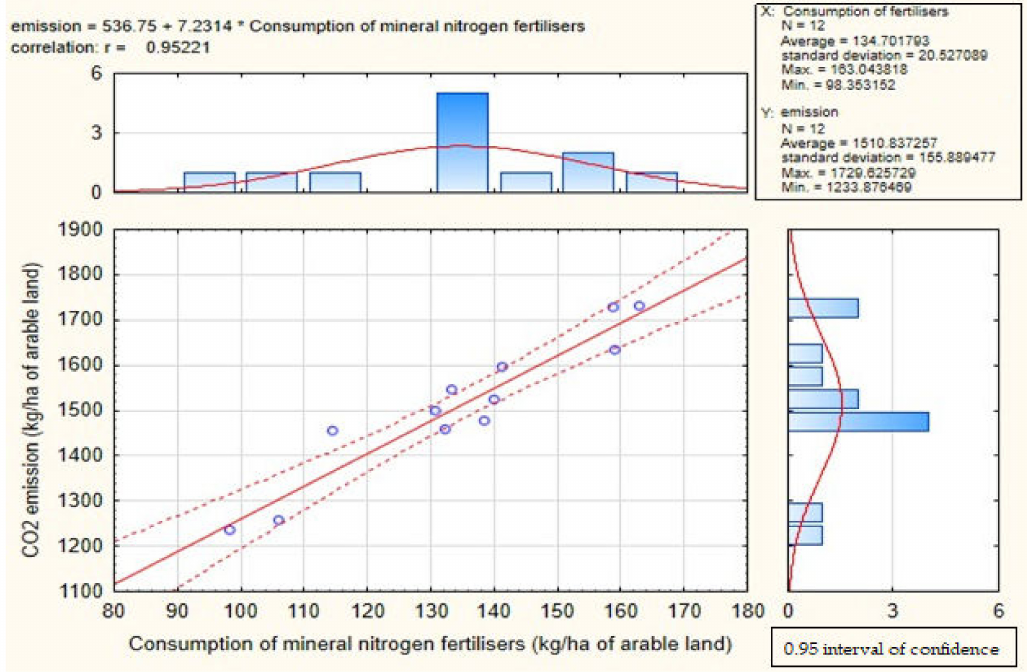
Figure A3. Results of correlations analysis: Czechia. Source: own calculation based on Eurostat. Note: purple dot: observation, red solid line: linear function, red dashed lines: 95% interval of